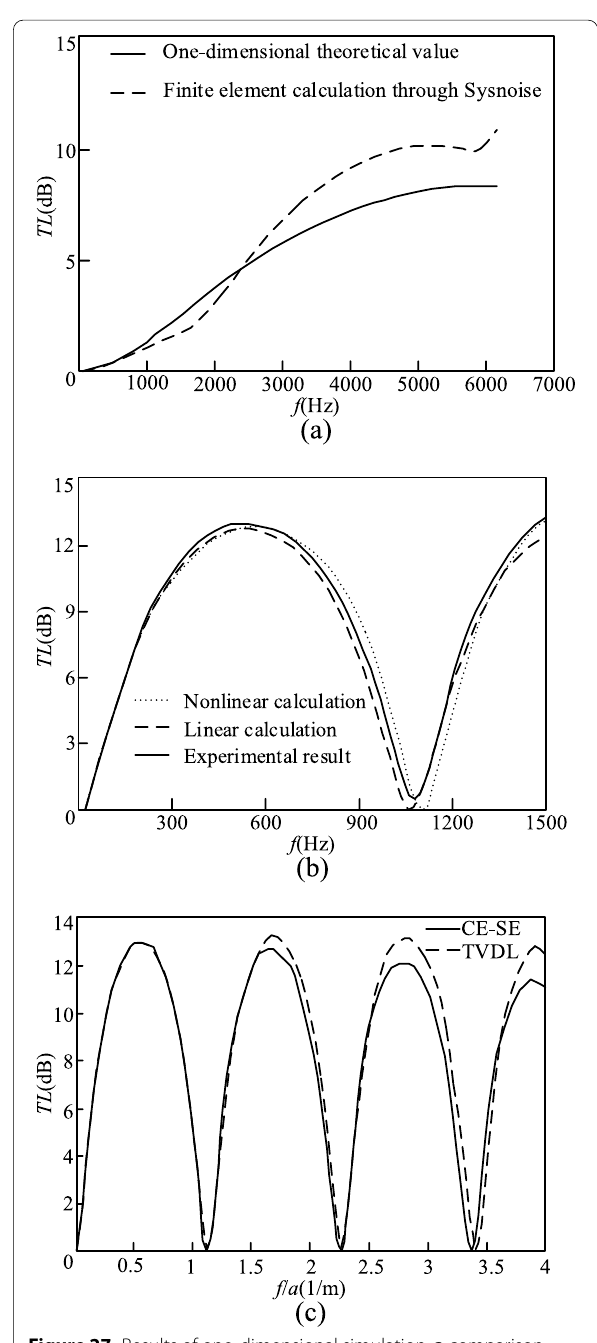
Figure 27 Results of one-dimensional simulation: a comparison of TL between calculated value and simulation result of insert-pipe water muffler, b comparison of simulation results and measured values of expansion chamber pulsation attenuator, c comparison of TL of different numerical schemes of expansion chamber pulsation attenuator